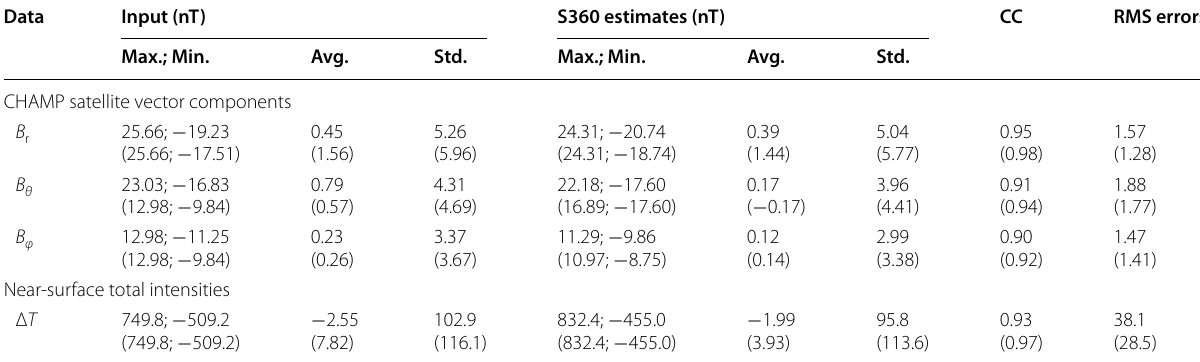
Table 1 Performance of the degree 360 Slepian joint satellite and near‑surface magnetic anomaly model (S360)